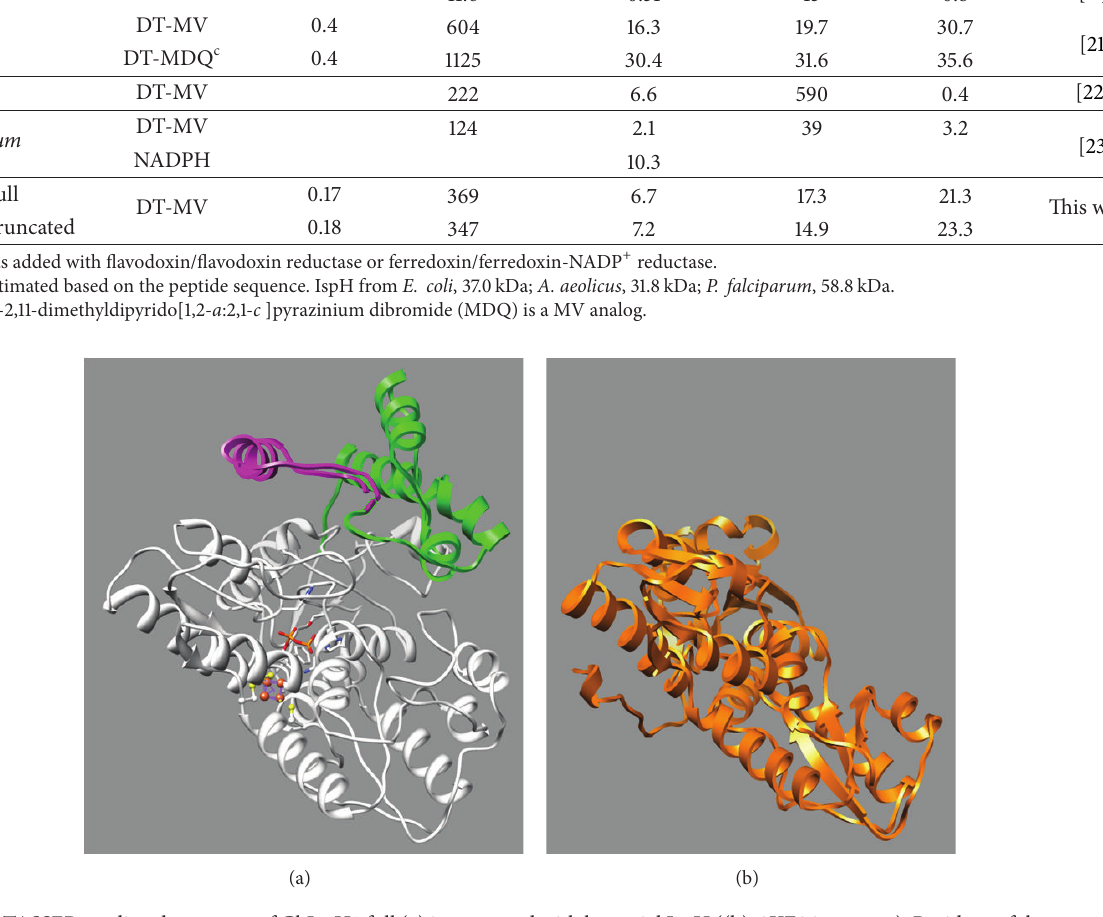
Figure 2: I-TASSER predicted structure of GbIspH1-full (a) is presented with bacterial IspH ((b), 3KE8 in orange). Residues of the conserved Cys, His, and Phe are depicted with ball and stick model, and the substrate HMBPP is represented with stick model. The extra N -terminal regions (magenta: 1–61, green: 52–131) were colored